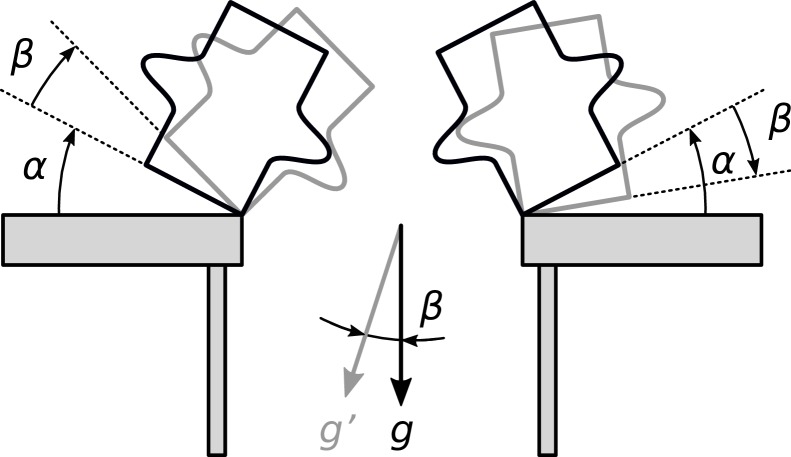
Theoretical predictions for the mirror-scene experiment.The hypothetical critical position for an object under normal condition (static background) are shown with black lines. The perceived gravity vector (g) is indicated. The critical angle for both left and right mirrored scenes is α. Under a perturbed condition, in which the perceived gravity vector (g’) is rotated clockwise by an angle β, the new theoretical critical positions of the object in both sides are shown with gray lines.